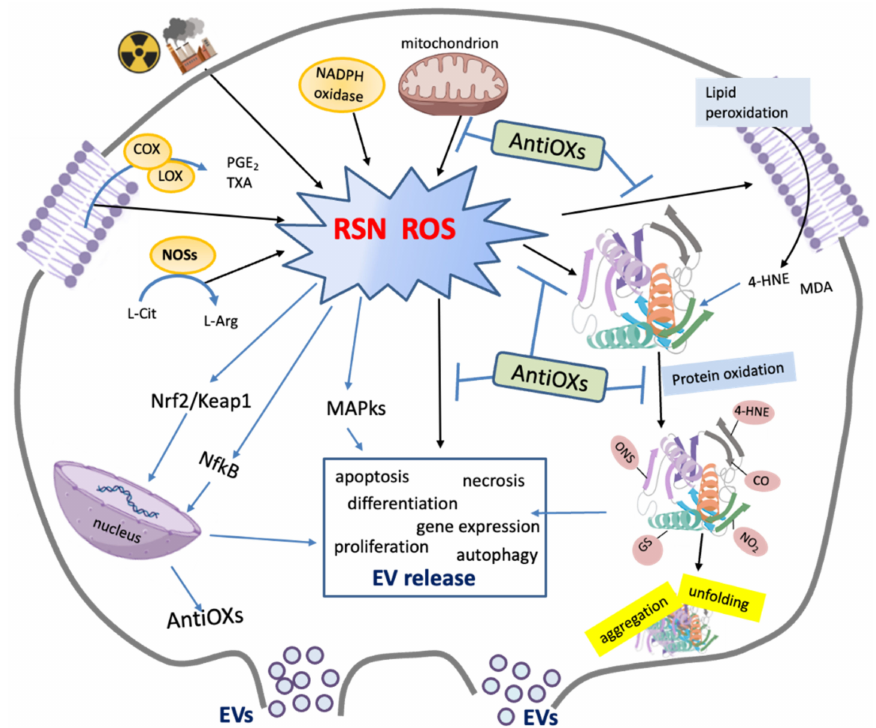
Figure 1. Schematic representation of main sources and effects of Reactive Oxygen Species (ROS) and Reactive Nitrogen Species (RNS). ROS and RNS are mainly generated by external stimuli (e.g., ionizing radiation and pollution), mitochondrial dysfunctions, NADPH oxidase activation, nitric oxide synthase (NOS), as well as by arachidonic acid (AA) cascade leading to the production of eicosanoids (e.g., prostaglandins (PGs), thromboxane A2 (TXA2)) by cyclo-oxygenase (COX) and lipoxygenase (LOX). Antioxidants (AntiOXs) can reduce the levels of ROS and RSN, repair or remove damaged molecules such as products of lipid peroxidation (i.e., 4-hydroxynonenal (4-HNE) and malondialdehyde (MDA)) as well as oxidated proteins (i.e., carbonylated (-CO), nytrosilated (-SNO), nitrated (-NO2), glutathionylated (-SG) proteins and 4-HNE adducts). ROS and some redox-modified proteins are involved in the signaling pathways (MAP-kinases and trascription factors (Nrf2, Nf κ B)) related to the modulation of cellular processes including EV release, antioxidant response and others (e.g., gene expression, cell proliferation, differentiation, migration, apoptosis,